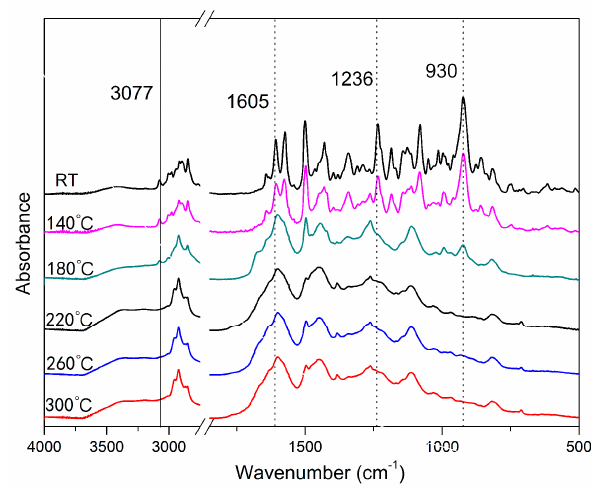
Figure 5. In situ FT-IR spectra of RES-al after various thermal treatments.